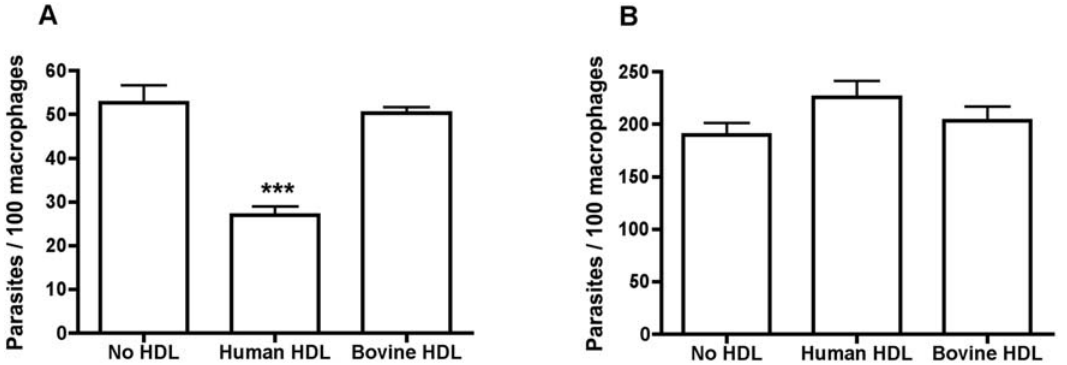
Figure 5. L.amazonensis promastigotes but not amastigotes are sensitive to lytic HDL within macrophages. BALB/c bone-marrow derived macrophages were infected with L. amazonensis promastigotes (A) or amastigote like forms (B) at a multiplicity of infection of 3:1, for 2 hours before the addition of human or bovine HDL (1.5 mg/ml) for 24 hours. The data represent the mean 6 SD of duplicate cultures of one typical experiment that has been repeated twice. *** p , 0.0001 compared to bovine HDL, ANOVA